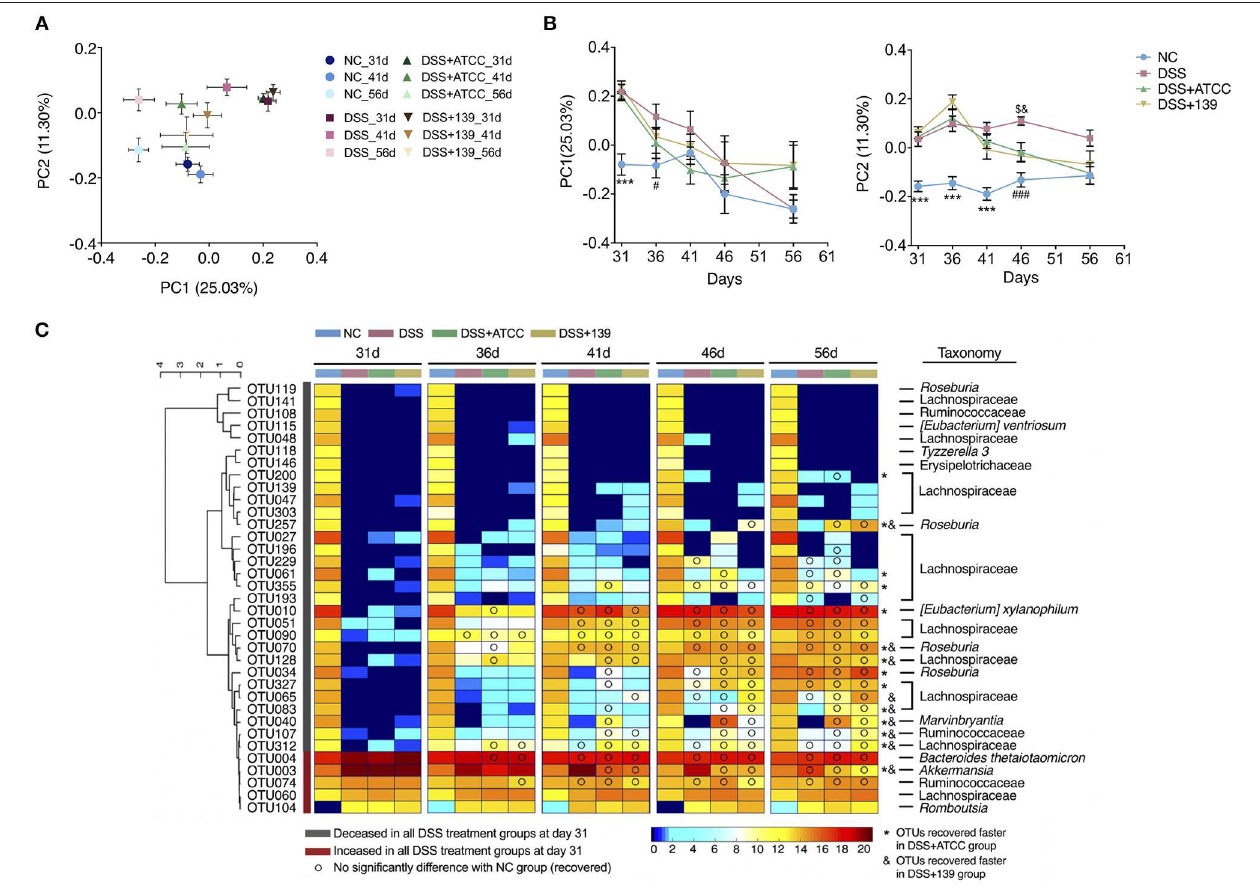
FIGURE 5 | Modulation of gut microbiota by DSS treatment or by DSS treatment and the two strains of A. muciniphila . (A) Bray-Curtis PCoA plot of day 31, 41, and 56 based on OTU abundance. (B) Variation of gut microbiota structure on PC1 and PC2 based on Bray-Curtis distance, n = 10 for each group before the 46 day time point, n = 5 for each group. Data are shown as means ± s.e.m. Values of each group were calculated by one-way analysis of variance (ANOVA) followed by Tukey’s post-hoc test. *** P < 0.001 compared to all three groups treated with DSS, ### P < 0.001 compared to the DSS group, $ P < 0.05 compared to the DSS + ATCC group, & P < 0.05 compared to the DSS + 139 group. (C) Heat map of 35 OTUs after DSS treatment during the alleviation period of mouse colitis. The color of the spots in the panel represent the mean relative abundance (log-transformed) of the OTUs in each group. The OTUs are clustered according to the Spearman correlation coefficient, n = 10 for each group before the 46 day time point, n = 5 for each group. The relative abundance of each DSS-treated group was compared to the NC group by Mann-Whitney U test. Compared to the relative abundance of the NC group at day 31, the taxonomy of OTUs increased significantly in all DSS-treated groups colored red, decreased significantly in all DSS-treated groups colored gray. OTUs recovered faster in mice gavaged with strain ATCC and are marked with *. OTUs recovered faster in mice gavaged with strain ATCC and are marked with